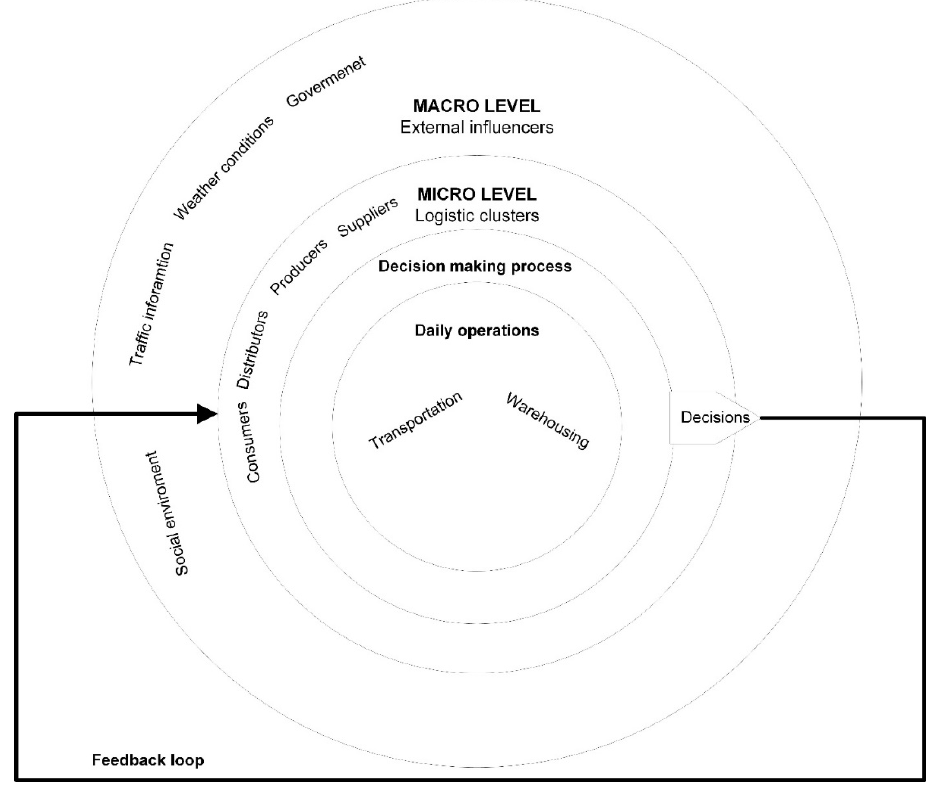
Figure 3. System Thinking Adaptation to Supply Chain Management, created by authors.